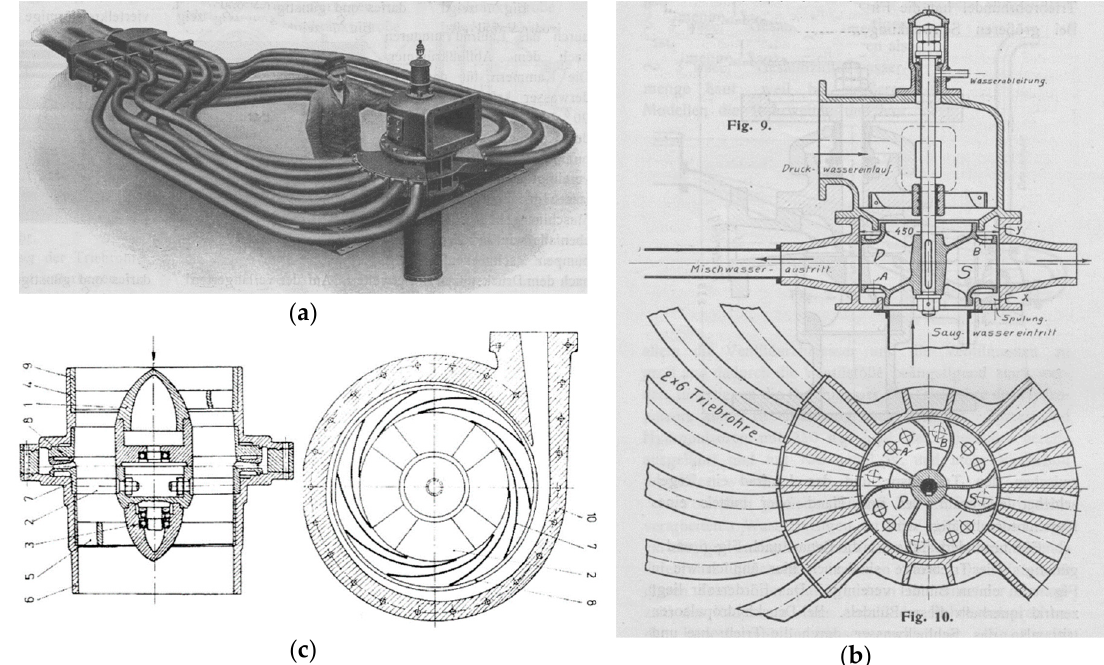
Figure 4. Di ff erent types of hybrid turbine-pumps: ( a ) Hydropulsor installed at Dretzel, Germany [85]. © Digitalisierung des Polytechnische Journal (http: // dingler.culture.hu-berlin.de / article / pj327 / ar327220). CC BY-NC-SA 3.0; ( b ) Impeller / runner of the Hydropulsor installed at Dretzel, Germany [85]. © Digitalisierung des Polytechnische Journal (http: // dingler.culture.hu-berlin.de / article / pj327 / ar327220). CC BY-NC-SA 3.0; ( c ) Longitudinal and transversal section of an hydraulic transformer (HT) [89]. (http: // www.afst.valahia.ro / images / documente / 2010 / issue2 / 2010-2-4-3-Man-Eugen-Teodor.pdf). CC BY.